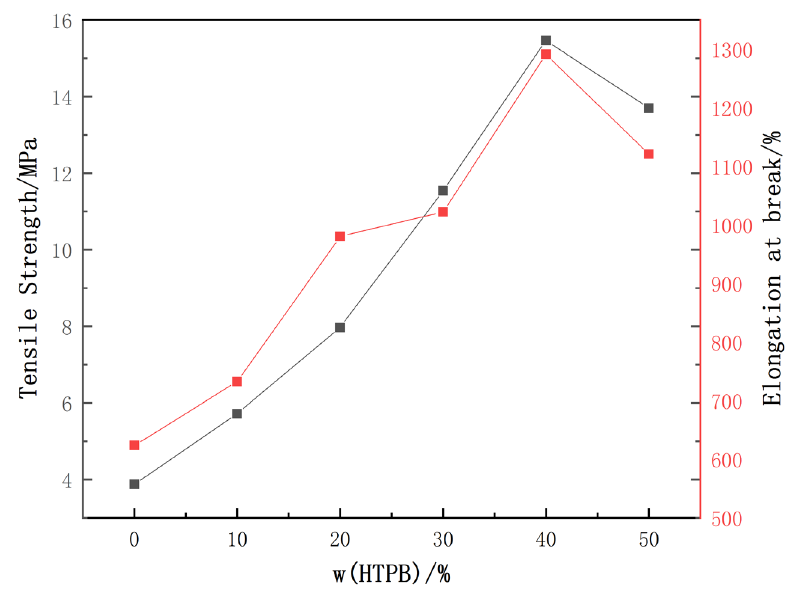
Figure 5. Mechanical properties of waterborne polyurethane films with different HTPB contents.